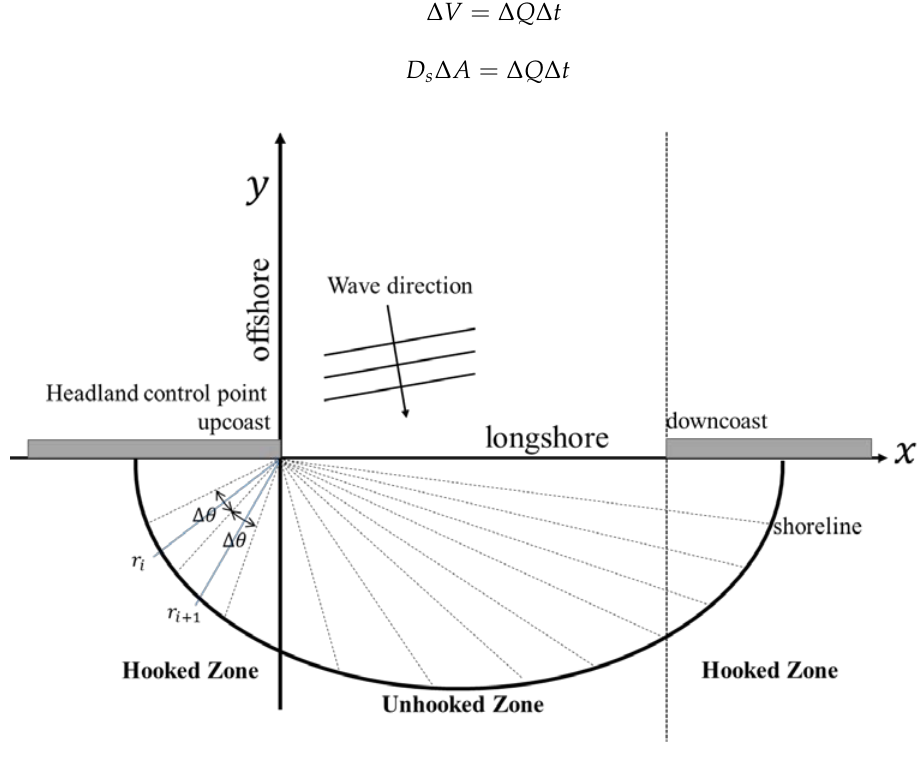
Figure 1. The schematic diagram of the shoreline planform of the crenulate-shaped bay.